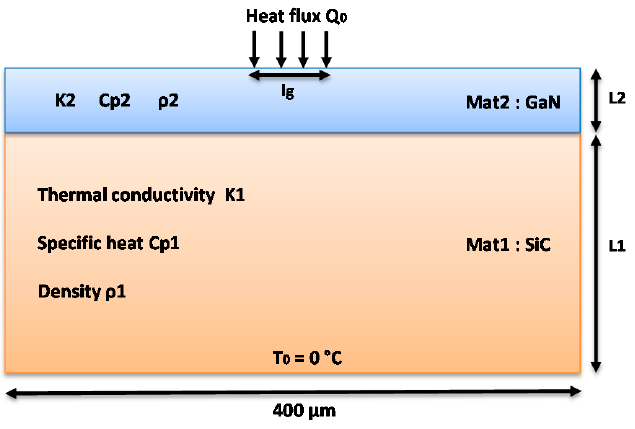
Figure 14. 2-D, two-layer structure.